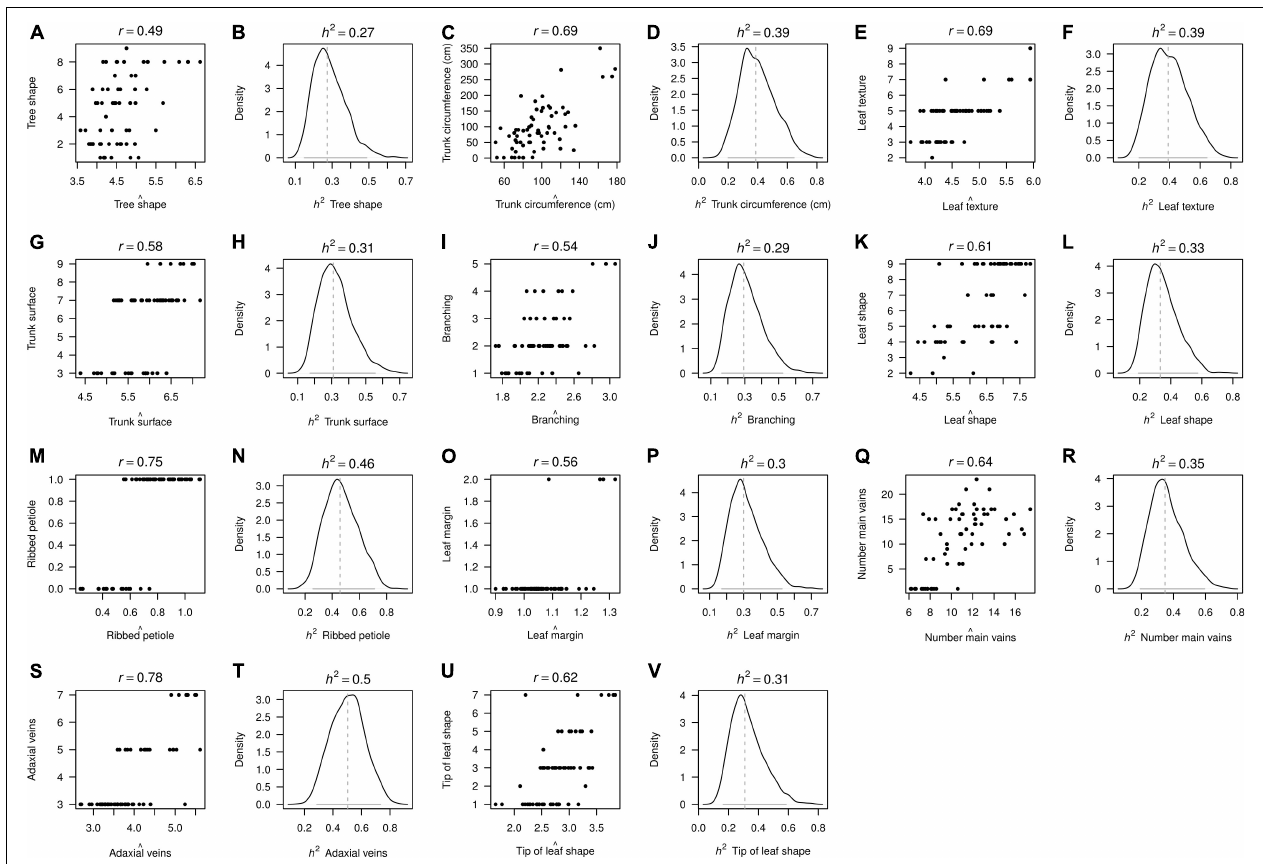
FIGURE 4 | Narrow-sense heritability ( h 2 ) posterior distributions for morphological traits measured in avocado “criollo” “plus trees” selected as seed donors for rootstocks of the cv. Hass. Model fits are depicted in the odd columns (A,C,E,G,I,K,M,O,Q,S,U) using Pearson’s correlation r score between the observed (y-axis) and the predicted (x-axis) trait values. Meanwhile, median values (vertical dashed lines) and the 95% confidence intervals (horizontal gray lines) are depicted in the even columns (B,D,F,H,J,L,N,P,R,T,V) . Different traits are sorted every second subpanel across rows according to the x-label in each